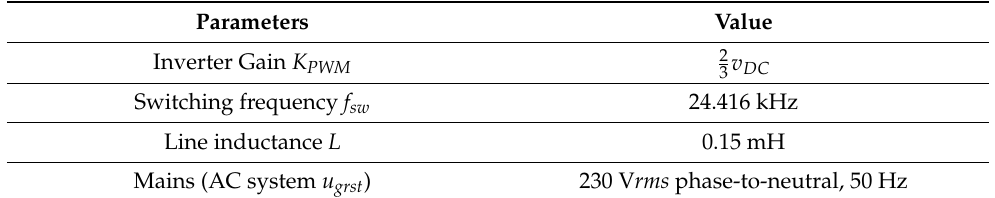
Table 1. Power subsystem parameters ( V DC = 800 V).